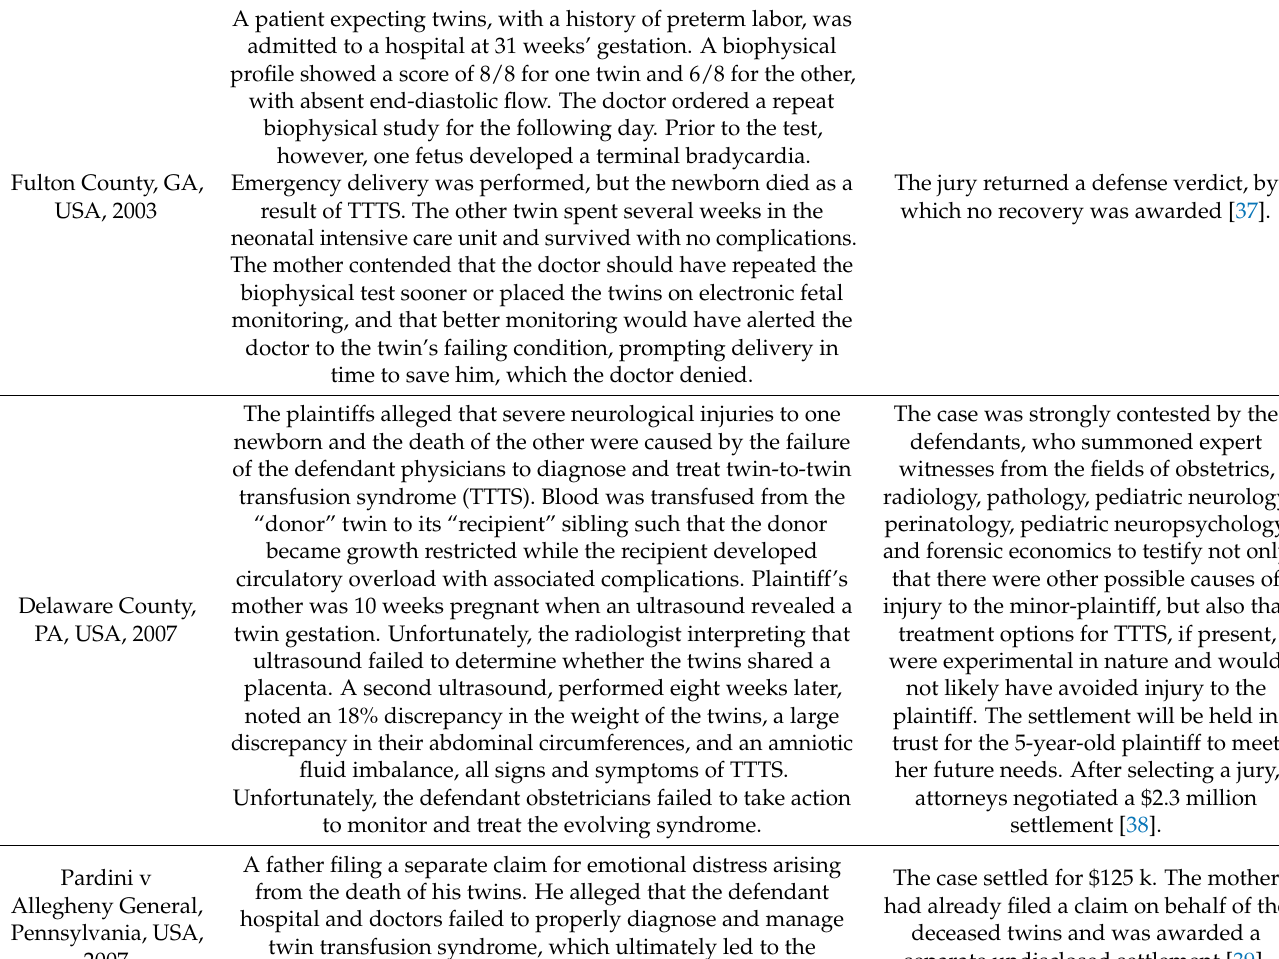
Table 2. Relevant case law involving TTTS (Sources: Justia, Lexis, Leagle, spanning 2000–2020). Location/Date Case Specifics Legal